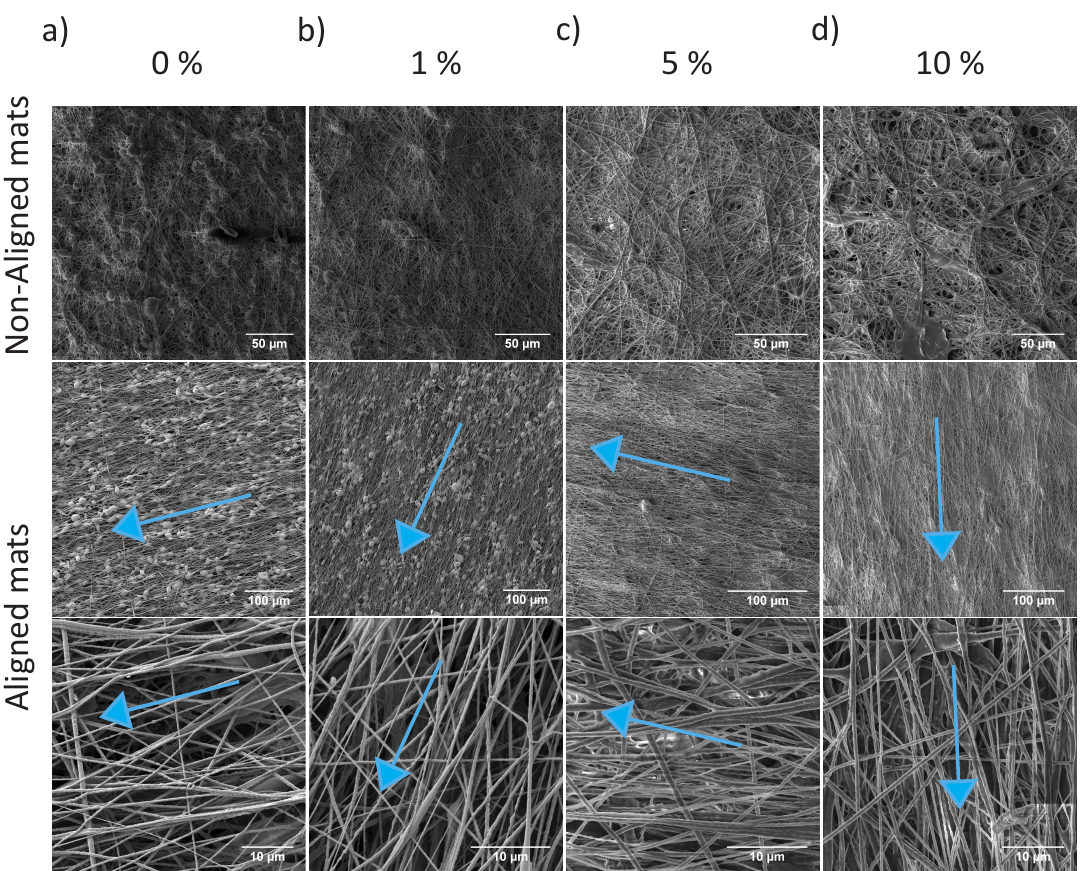
Figure 3. SEM images of electrospun PU/P-tCNC mats collected on a rotating drum at either 11m/min (top row) or 330m/min (bottom row), the latter resulting in the alignment of fibers within the mats. The blue arrows indicate the rotational direction of the